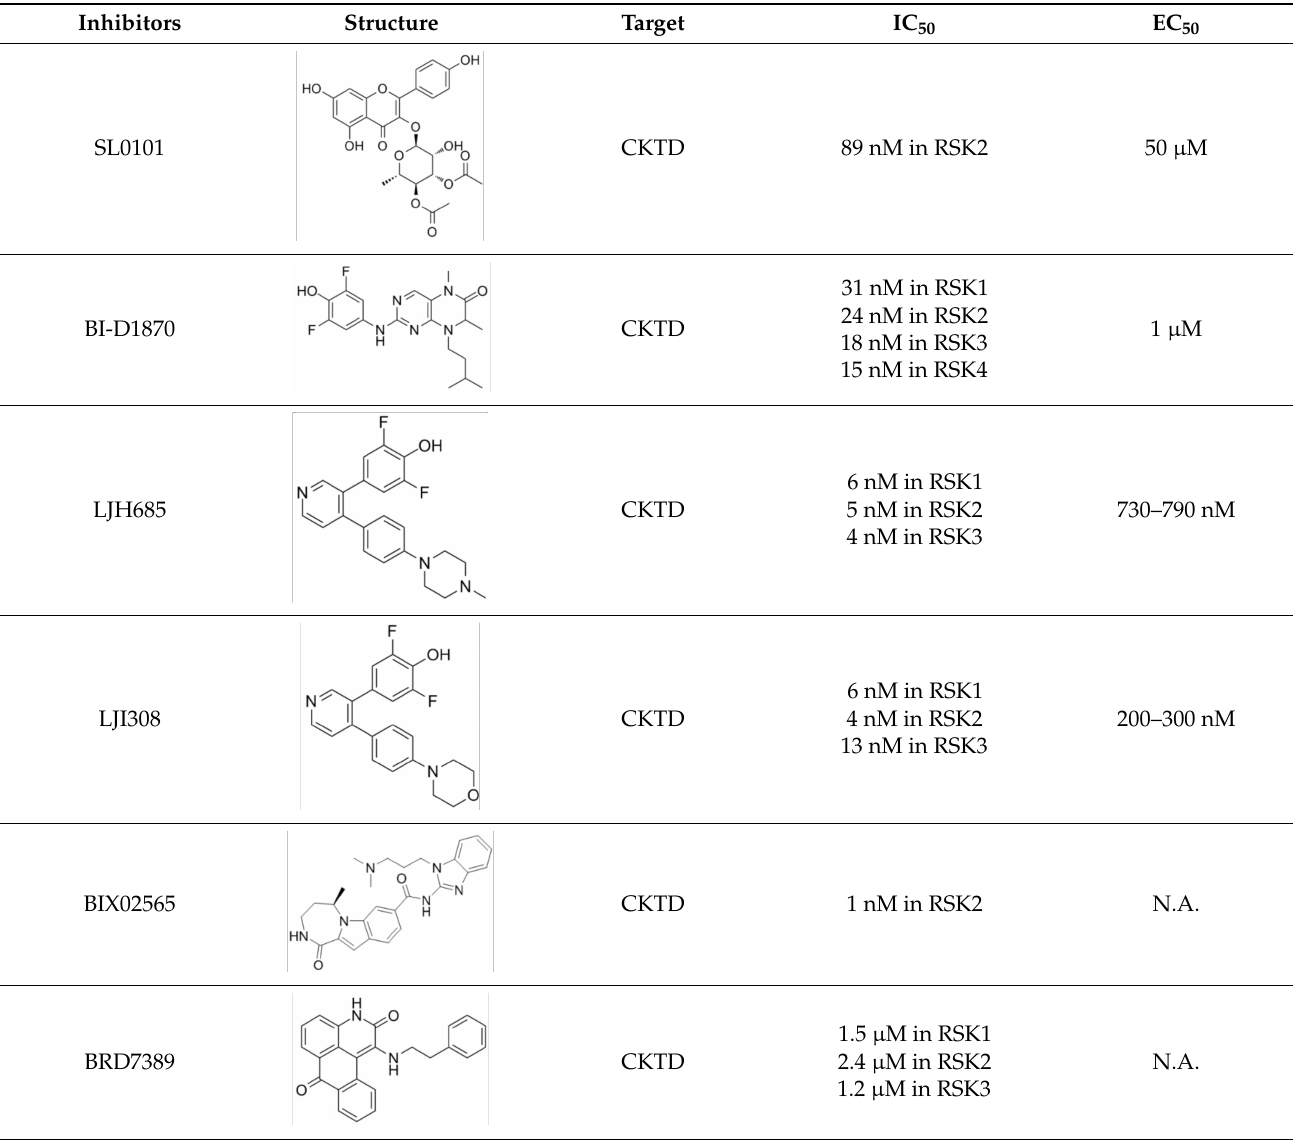
Table 1. Summary of pharmacological inhibitors of RSK isoforms.